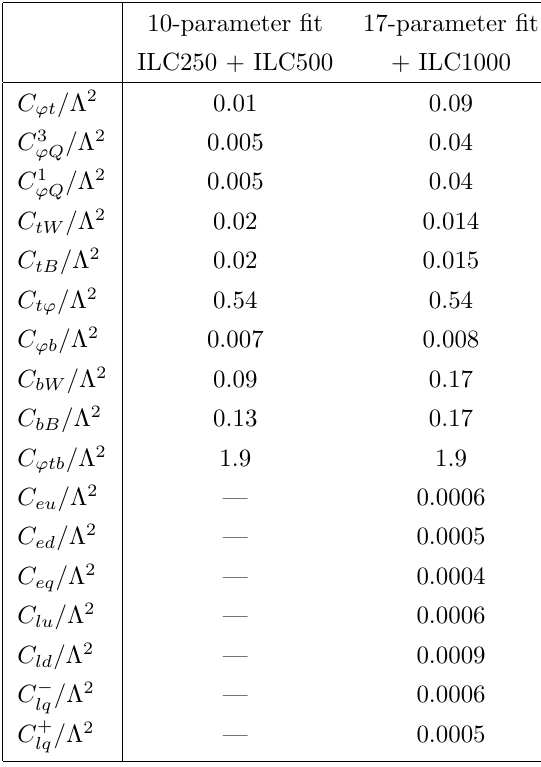
Table 3 . The marginalized 68% probability bounds on the dimension-six operator coe(cid:14)cients in units of TeV (cid:0) 2 . The results in the (cid:12)rst column are based on a ten-parameter (cid:12)t on pseudo-data from two ILC runs, with an integrated luminosity of 2 ab (cid:0) 1 at 250 GeV and 4 ab (cid:0) 1 at These results are identical to those of the ILC500 entry in (cid:12)gure 4. The second column presents the results of the seventeen-parameter (cid:12)t. It includes an additional run, with an integrated luminosity p of 8 ab (cid:0) 1 at s = 1 TeV and seven additional degrees of freedom corresponding to two-lepton-two- third-generation-quark